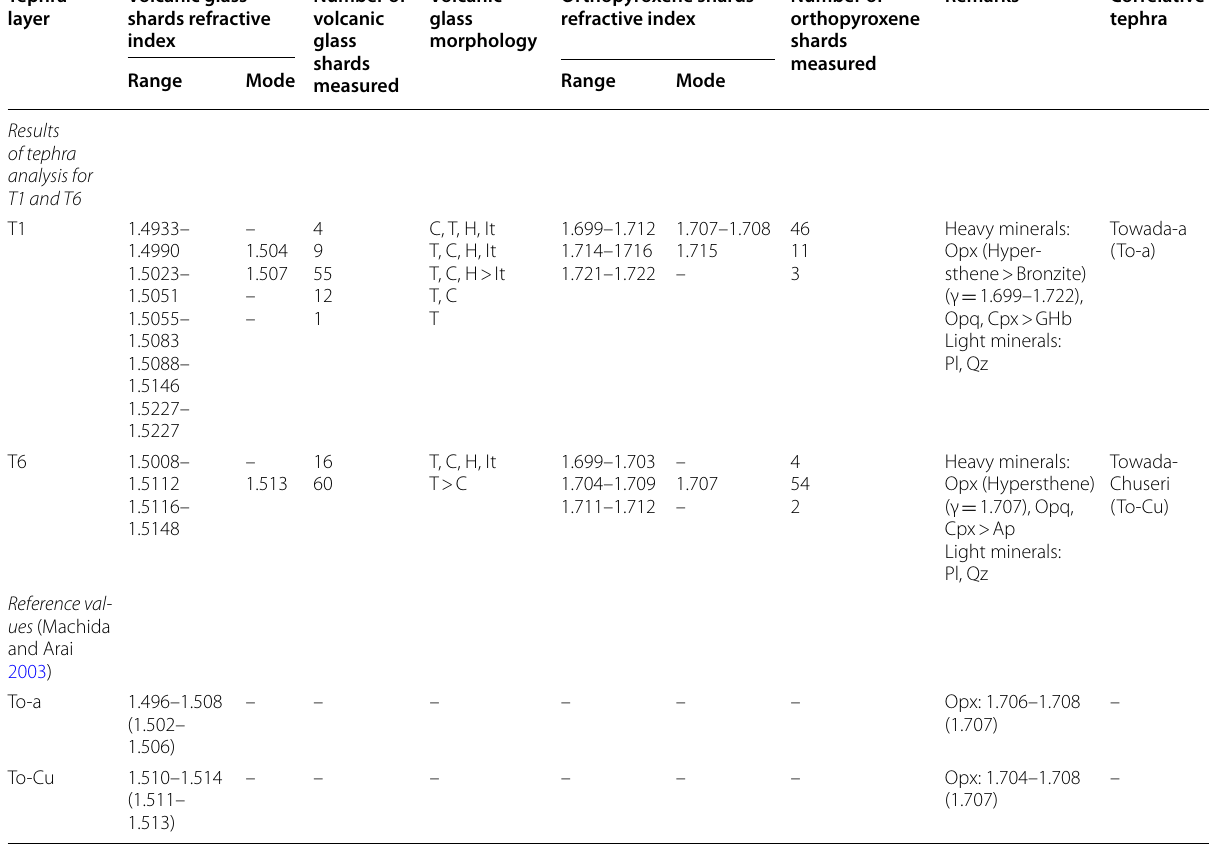
Glass shards morphology: H: large broken type, T: fibrous pumice type, C: intermediate from between H‑type and T‑type, It: irregular type. Heavy minearls: Opx: orthopyroxene, Cpx, clinopyroxene, GHb: green hornblende, Ap: apatite, Opq: opaque minerals. Light minerals: Qz: quartz, Pl: plagioclase Table 4 Conventional radiocarbon ages obtained from the core samples H02, Ha8 and H04 Sample